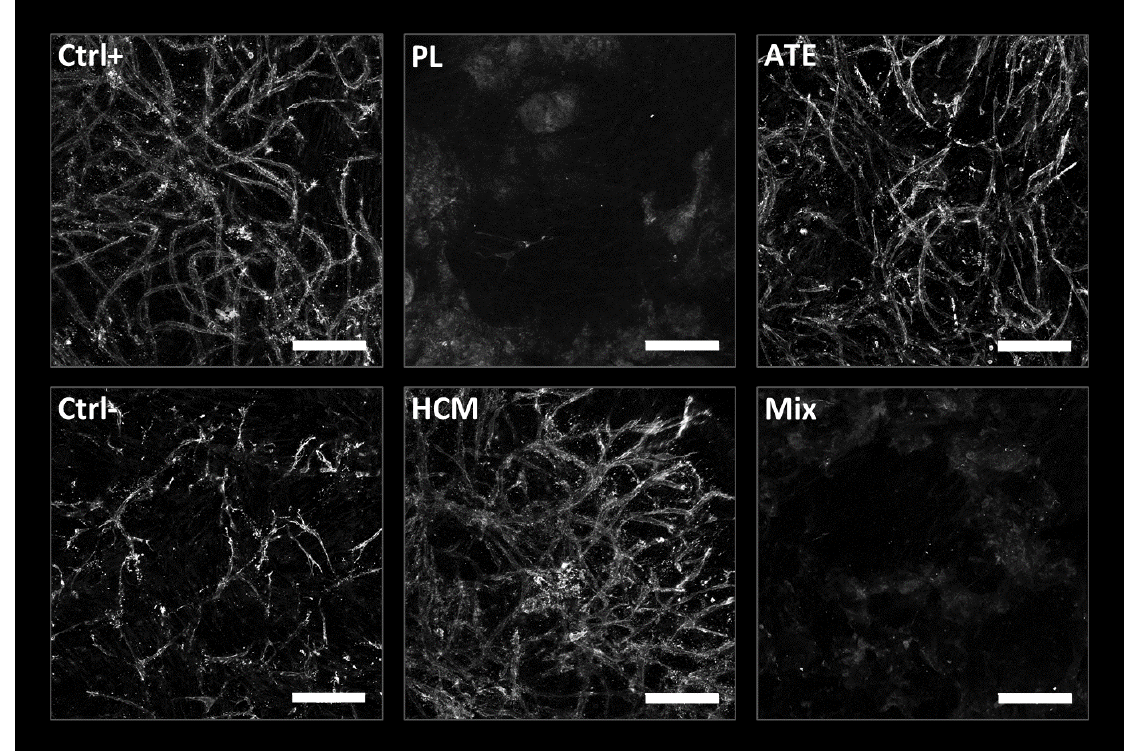
Figure 7. Prevascular structures formed by co-culture of hBM-MSC and HUVEC on functionalized mineralized collagen scaffolds (CD31 staining, laser scanning microscopy, scale bar = 200 µm).